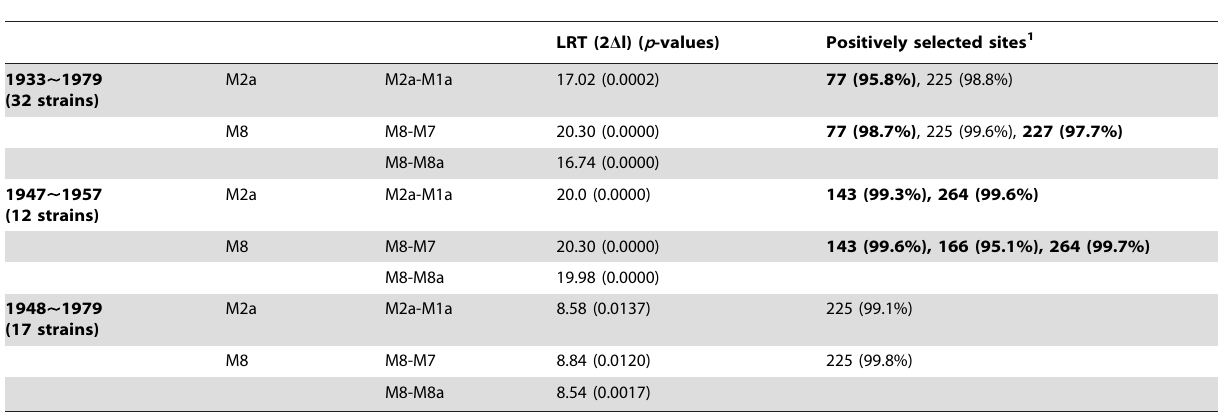
Table 5. LRT tests and codons under positive selection for HA 1 sequences of egg-adapted human A(H1N1) influenza viruses between 1933-1979.